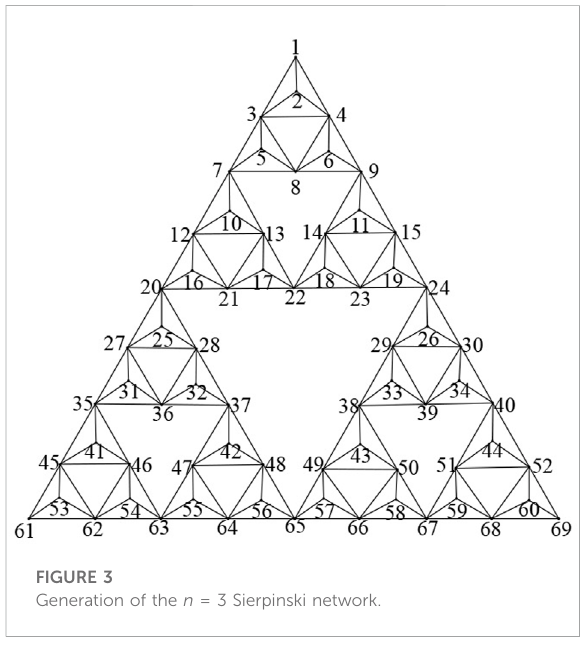
FIGURE 3 Generation of the n = 3 Sierpinski